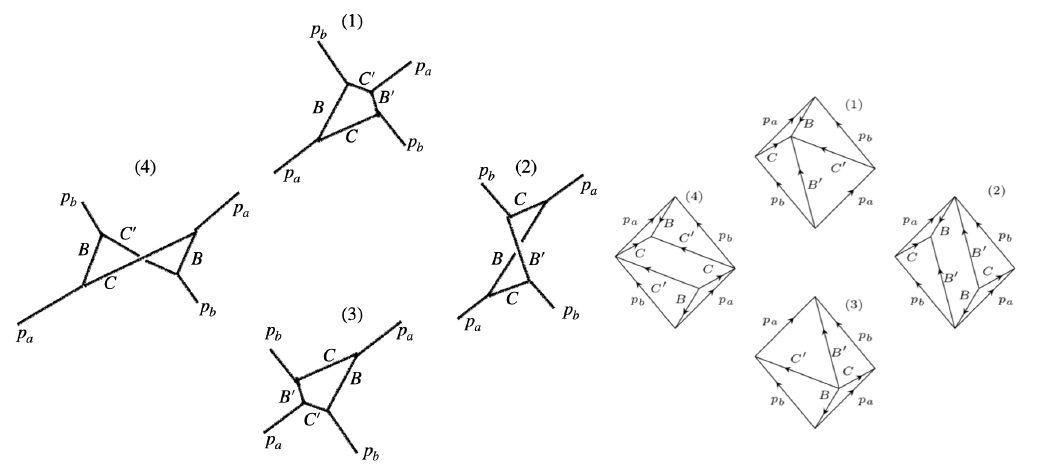
Figure 5 . A network of singular Feynman diagrams (on the left) and their on-shell dual descriptions (on the